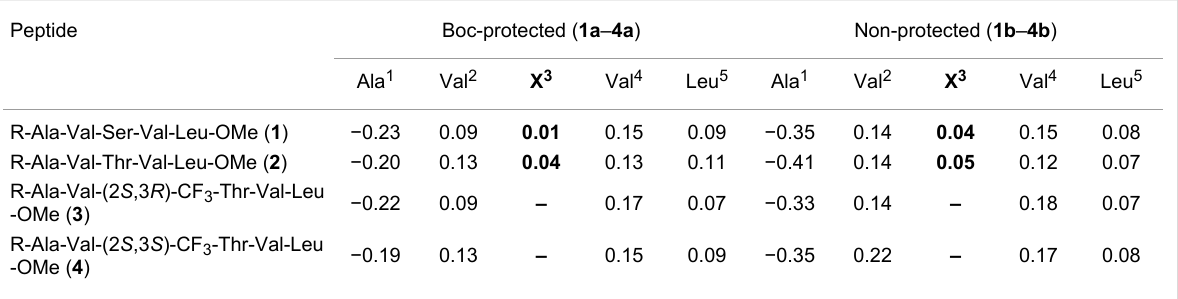
Table 1: 1 H α chemical shift deviations (CSD) of residues in pentapeptides 1a – 4a and 1b – 4b in CD 3 OH (298 K). Peptide